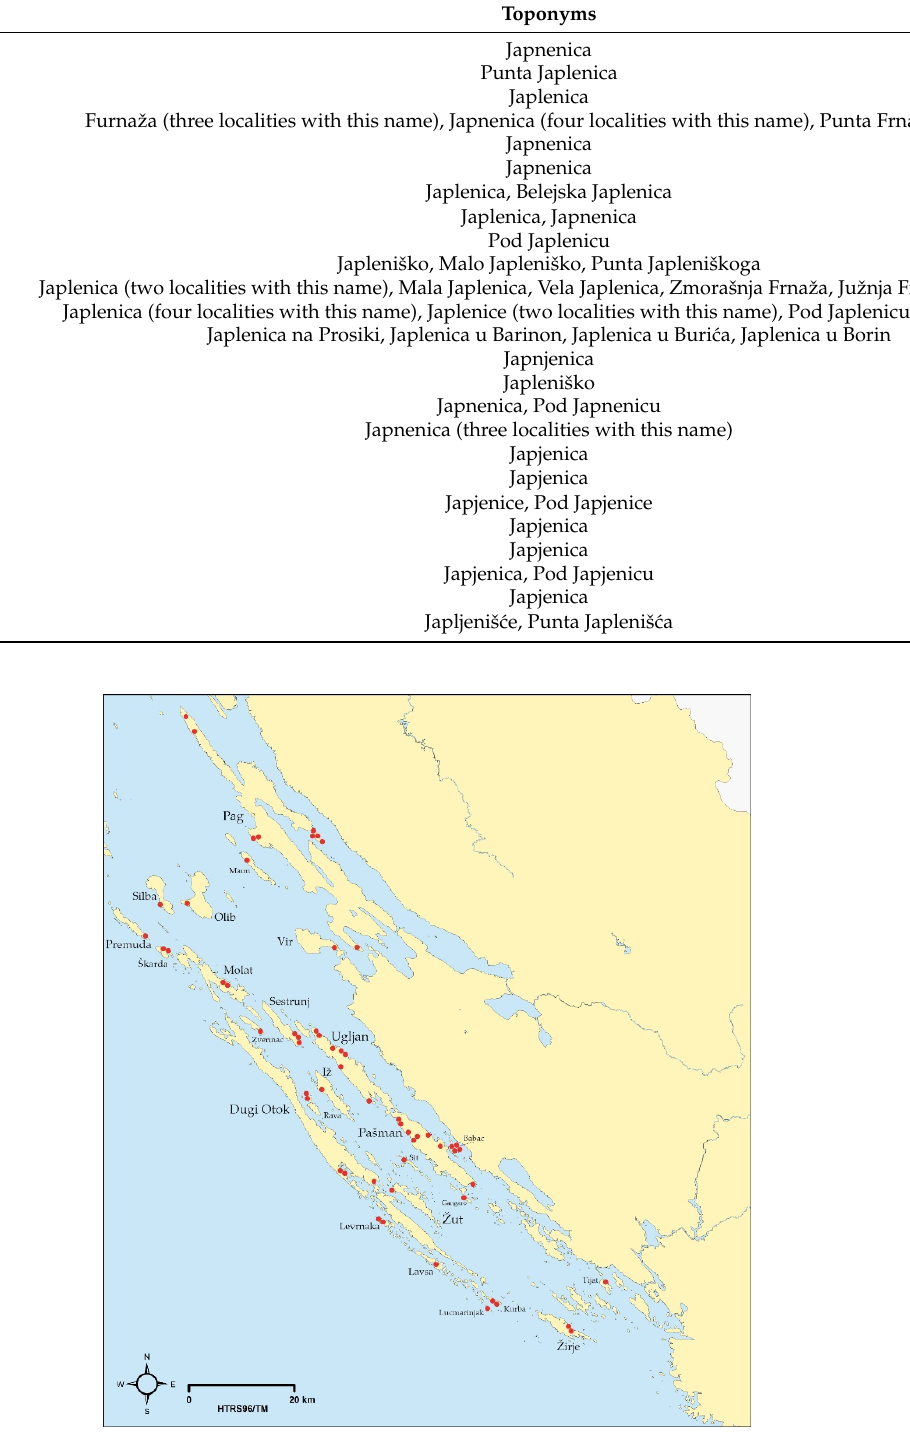
Figure 10. Geographical positions of toponyms in the northern Dalmatian islands referring to the production of lime.